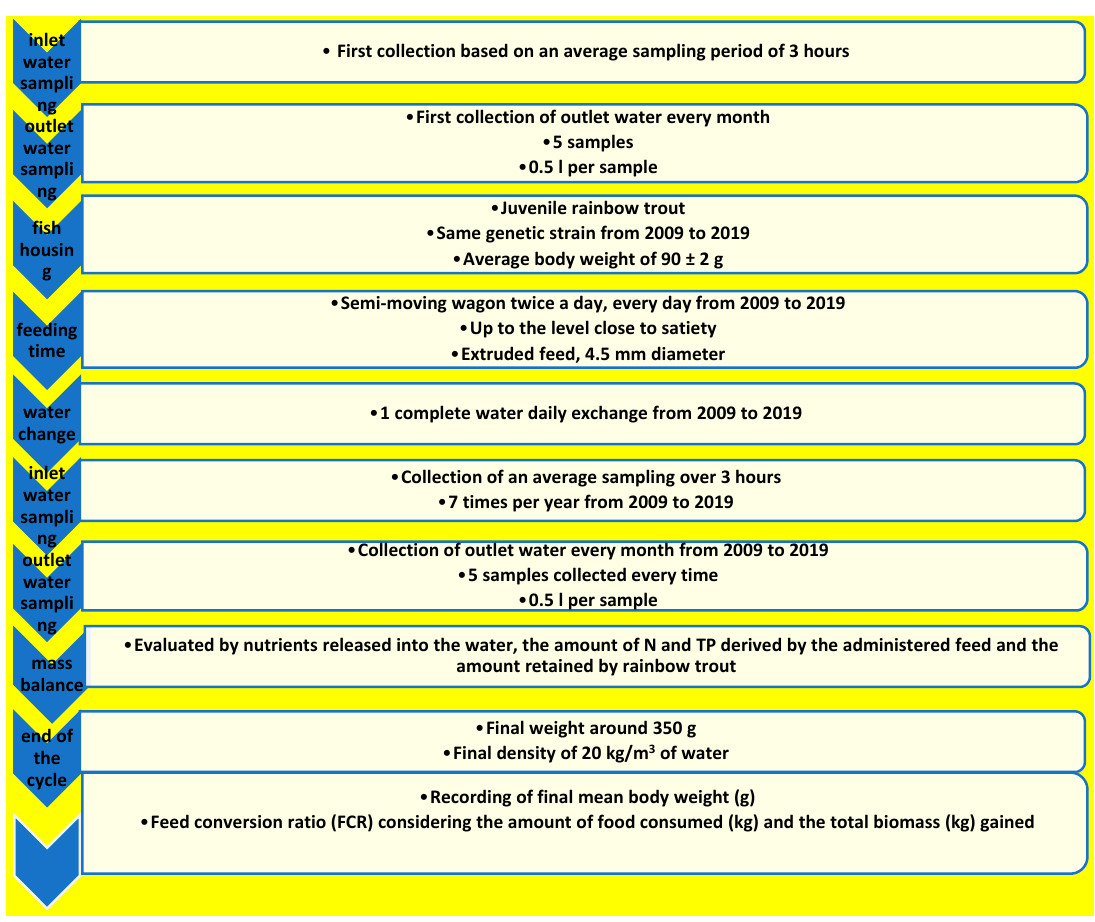
Figure 1. Diagram showing the experimental design adopted during the 10 years of the study.